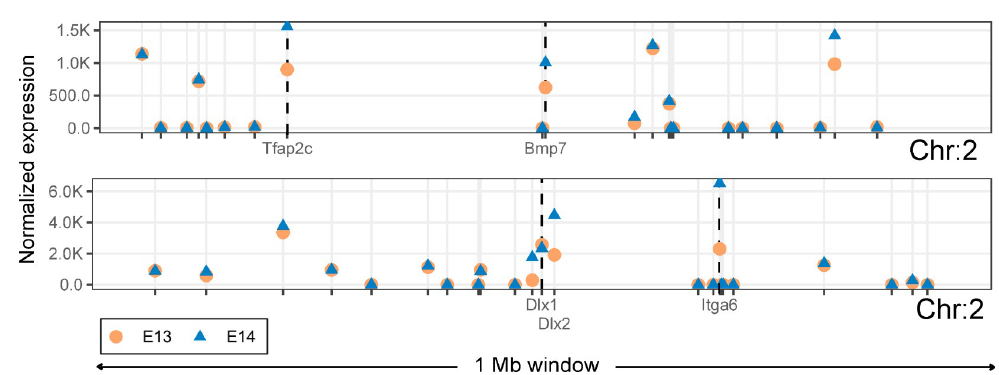
Fig 9. Differentially expressed genes in the same neighbourhood interfere with the detection of differentially expressed genes by DELocal. DELocal failed to identify Bmp7 due to differential expression patterns of its neighbouring genes (top). Dlx1 and Dlx2 are p aralogous tooth genes which are in the same neighbourhood (bottom). Only tooth developmental genes are labelled